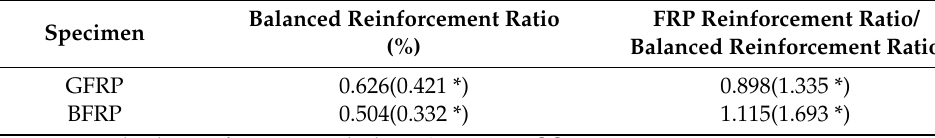
Table 4. Balanced reinforcement ratio of reinforced concrete slab.